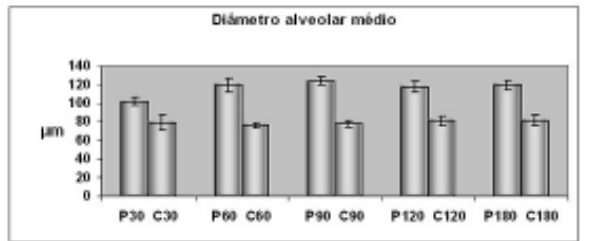
Fig. 4 – Diâmetro alveolar médio (em µm), nos grupos papaína e controle, nos diferentes períodos avaliado s.